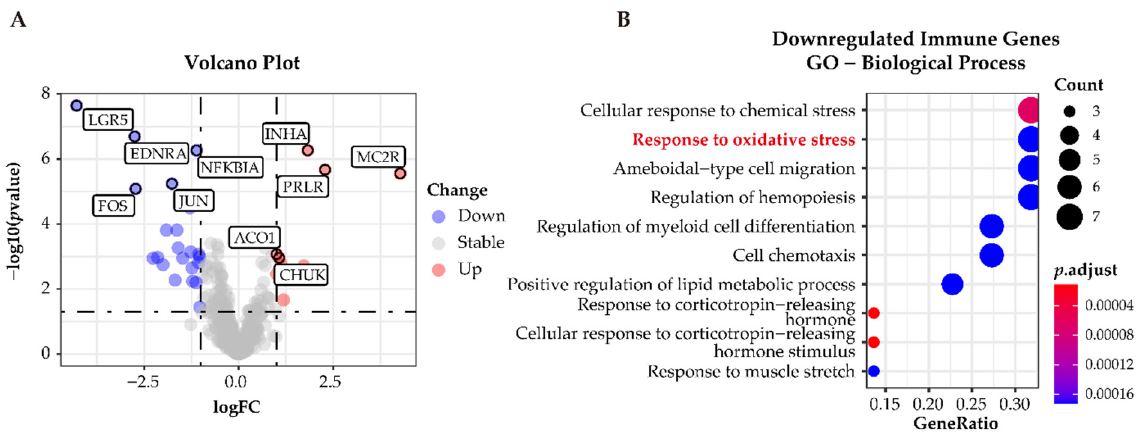
Figure 7. Functional characterization of immune-related differentially expressed genes in APAs versus paired adjacent zona glomerulosa (ZG). ( A ) Volcano Plot showing immune-differentially expressed genes (adjust p -value < 0.05 and |log 2 FC| > 1) in APA versus adjacent ZG (GSE64957). Each point represents a gene. Red and Blue dots represent upregu- lated and downregulated immune-differentially expressed genes, respectively. ( B ) GO analysis of downregulated im- mune-differentially expressed genes in ( A ). APA, aldosterone-producing adenoma; ZG, zona glomerulosa.